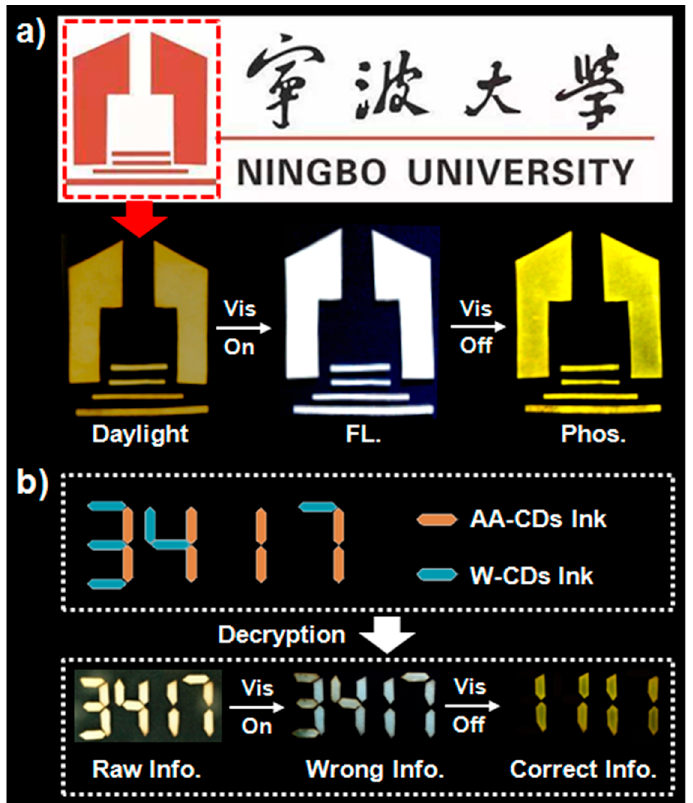
Figure 5. ( a ) Images of the badge of Ningbo University (made by filter paper that soaked in AA-CDs ink) under daylight, and visible light (420 nm) irradiation on and off, respectively. ( b ) Images of “3417” (made by filter paper that soaked in AA-CDs ink andinterference fluorescent security ink (W-CDs) ink) under daylight, and visible light (420 nm) irradiation on and off, respectively.